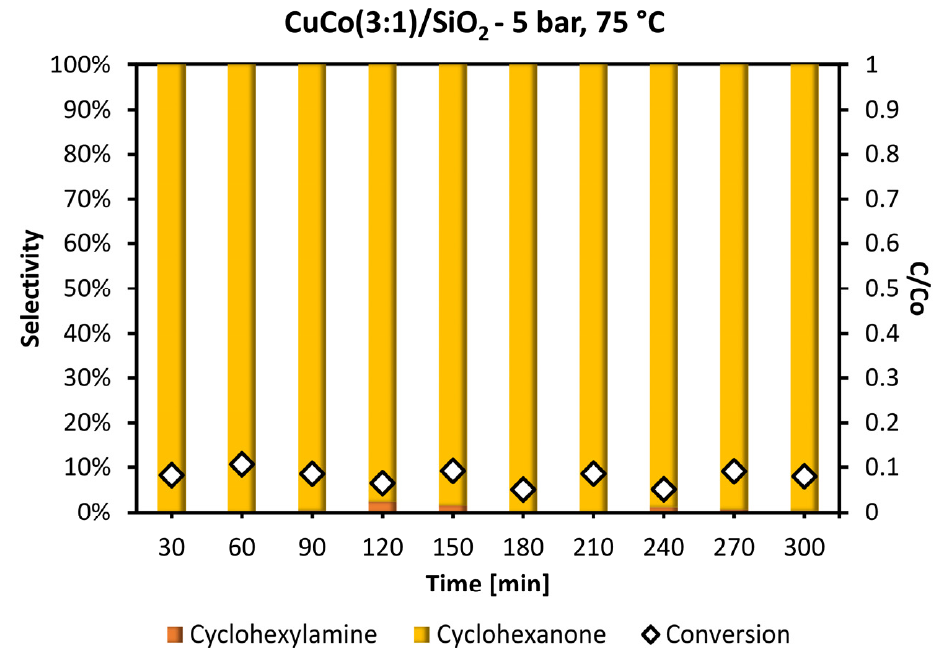
Figure 13. Stability test of CuCo(3:1)/SiO 2 in catalytic hydrogenation of nitrocyclohexane in liquid flow conditions (5 bar, 75 °C).